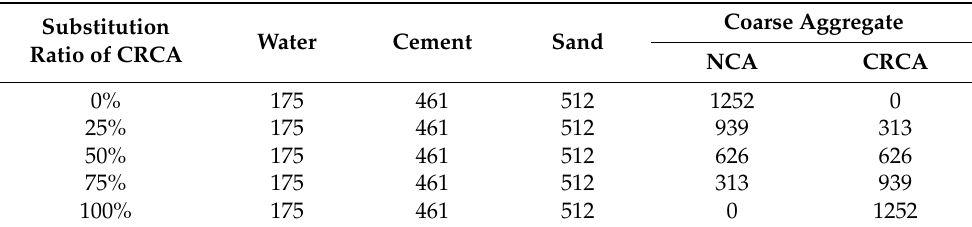
Table 2. Mix proportions of recycled aggregate concrete (RAC) with different coarse aggregate substitution ratios (unit: kg/m 3